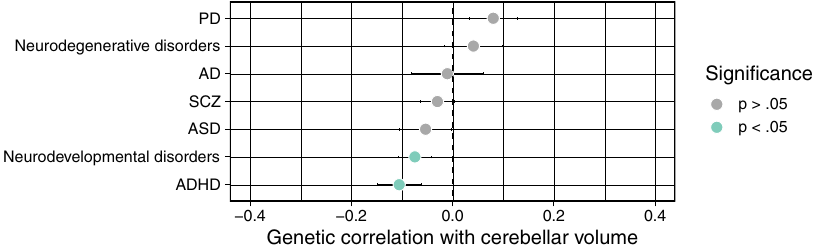
Fig. 3 Global genetic correlations between cerebellar volume and disease. Global genetic correlations and standard errors as estimated in LDSC between cerebellar volume and neurodevelopmental and neurodegenerative disorders (Supplementary Data 13). Although none of the traits survived Bonferroni correction for the number of traits tested, we did observe a slight gradient of negative r g with neurodevelopmental disorders to less negative and slightly positive r g with neurodegenerative disorders. To investigate this further, we meta-analysed the ADHD, ASD and SCZ summary statistics to represent the genetic signal of the overarching neurodevelopmental disorder dimension and similarly meta-analysed PD and AD summary statistics to capture the genetic signal of the neurodegenerative disorder dimension (see “ Methods ”